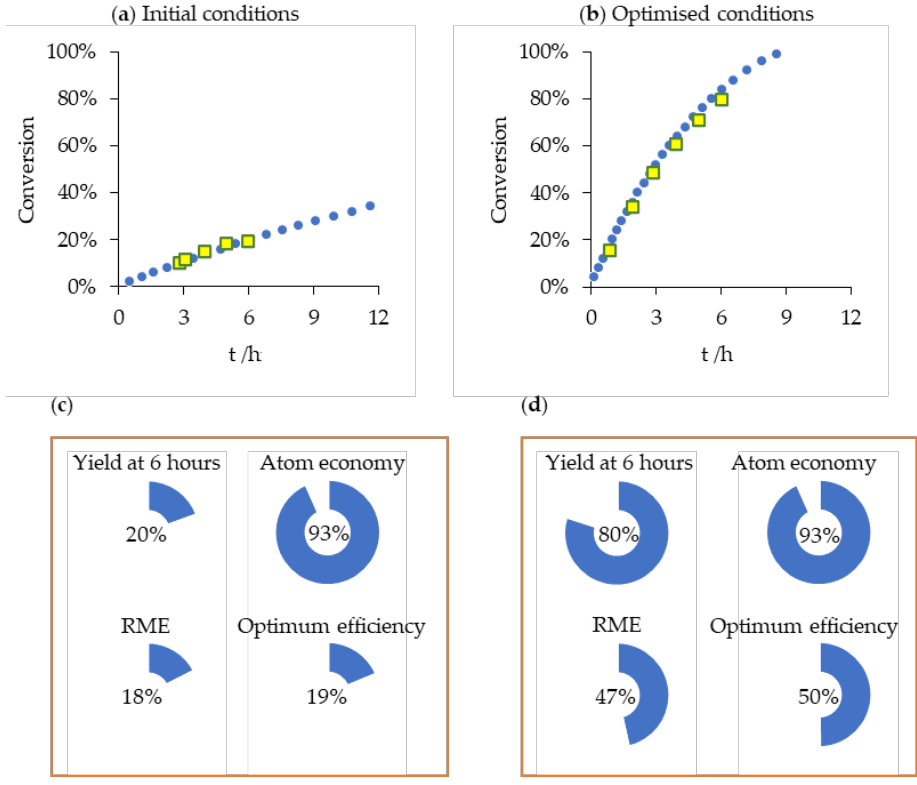
Figure 5. Rate acceleration of an amidation reaction in toluene. ( a ) Initial conditions (0.5 M 4-phenylbutyric acid, 0.55 M benzylamine, 100 ◦ C); ( b ) Optimized conditions (1.1 M 4-phenylbutyric acid, 0.55 M benzylamine, 111 ◦ C). Blue (circular) data points are predicted conversions. Yellow (square) data points represent experimental data. Metrics ( c ) prior to; and ( d ) after optimization are